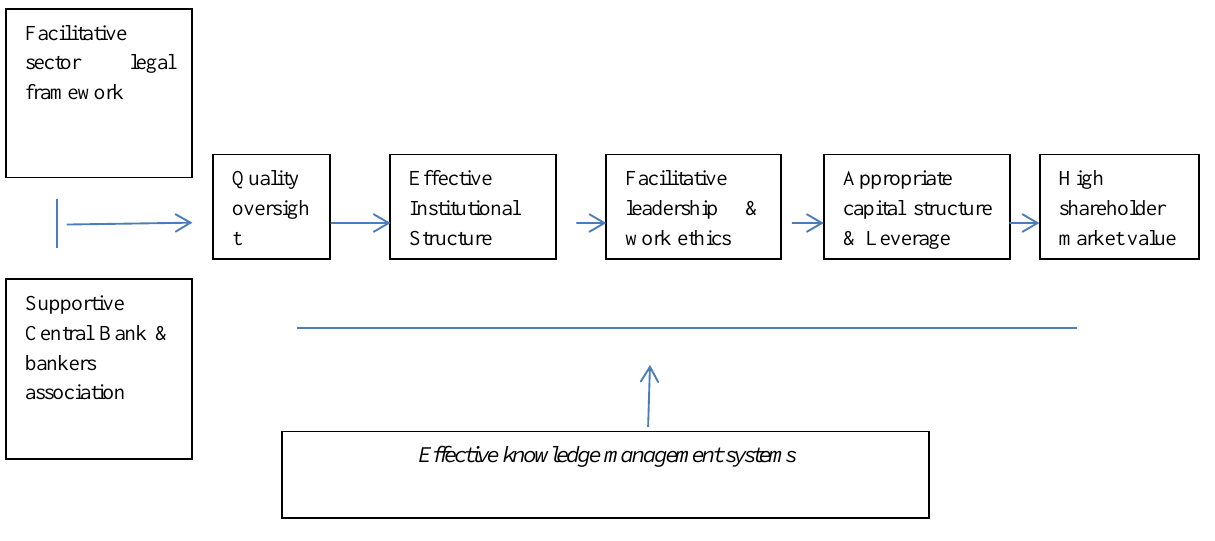
Fig.6: Credit risk and shareholder value maximization pathway